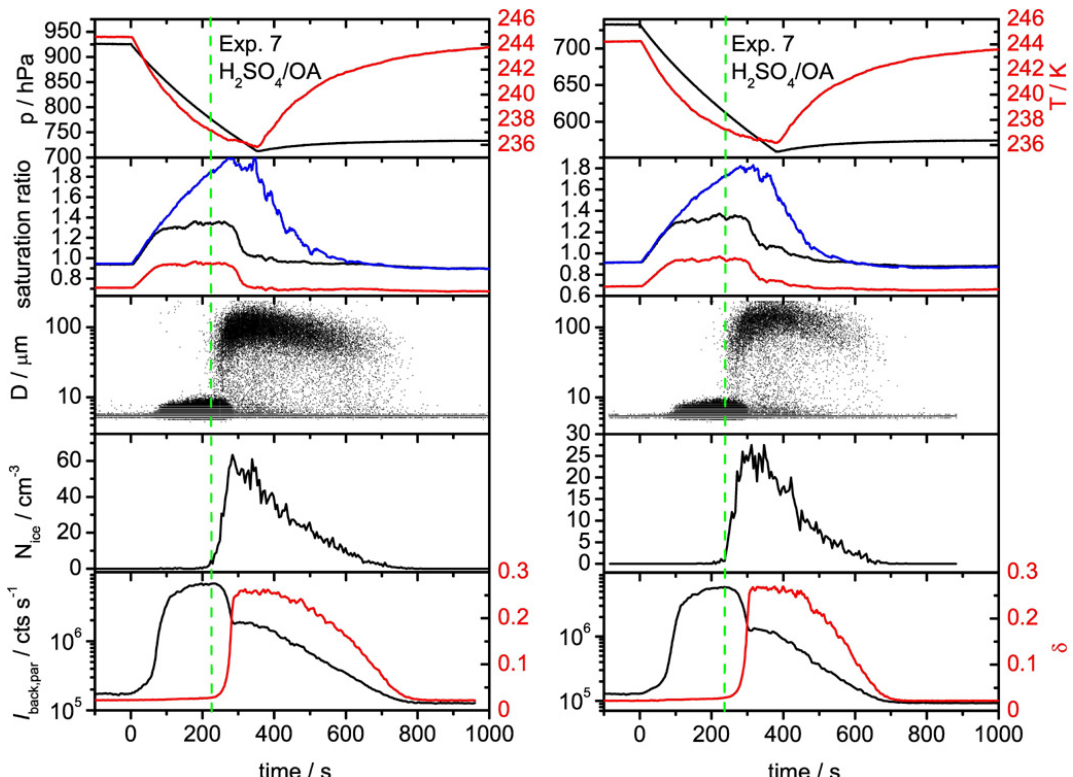
Fig. 14. Time series of various AIDA records during two consecutive expansion cooling cycles from Exp. 7 that were started at 244K. The individual panels show the same measurements as in Fig.